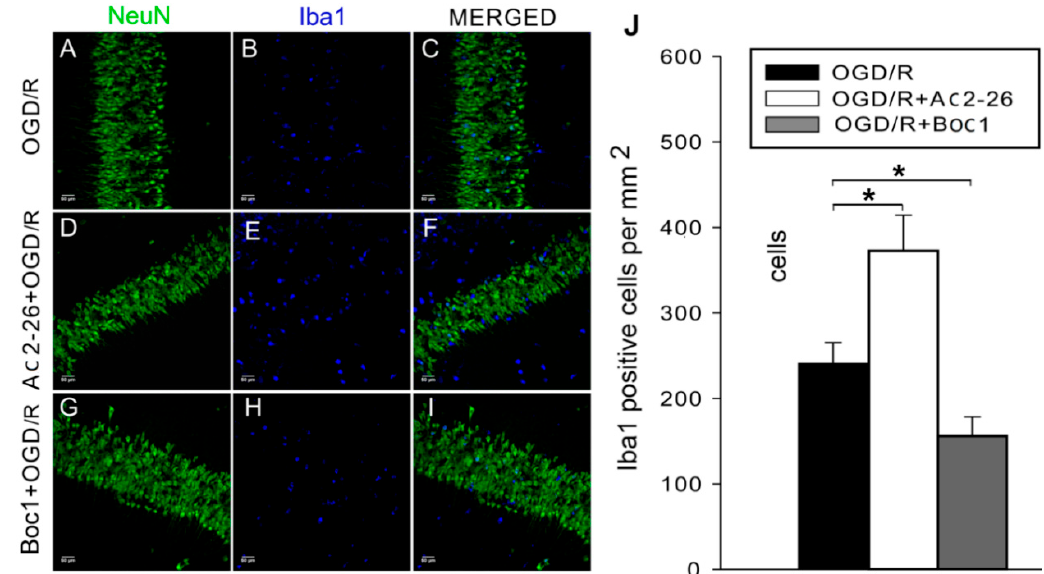
Figure 5. The extent of microglial activation induced by oxygen–glucose deprivation/reperfusion (OGD/R) was altered by Ac2-26 and Boc1 treatment. ( A – I ) Examples of neuron-specific nuclear protein (NeuN)-labeled neurons ( green ) and ionized calcium binding adapter molecule 1 (Iba1)-labeled microglia ( blue ). Scale bar: 50 µ m; ( J ) after OGD/R treatment, the number of Iba1-positive particles was increased by Ac2-26 treatment (1 µ M) and significantly decreased by Boc1 (4 µ M) in CA1. The data are expressed as the mean ± standard error of the mean (SEM) ( n = 6–8). * p < 0.05.